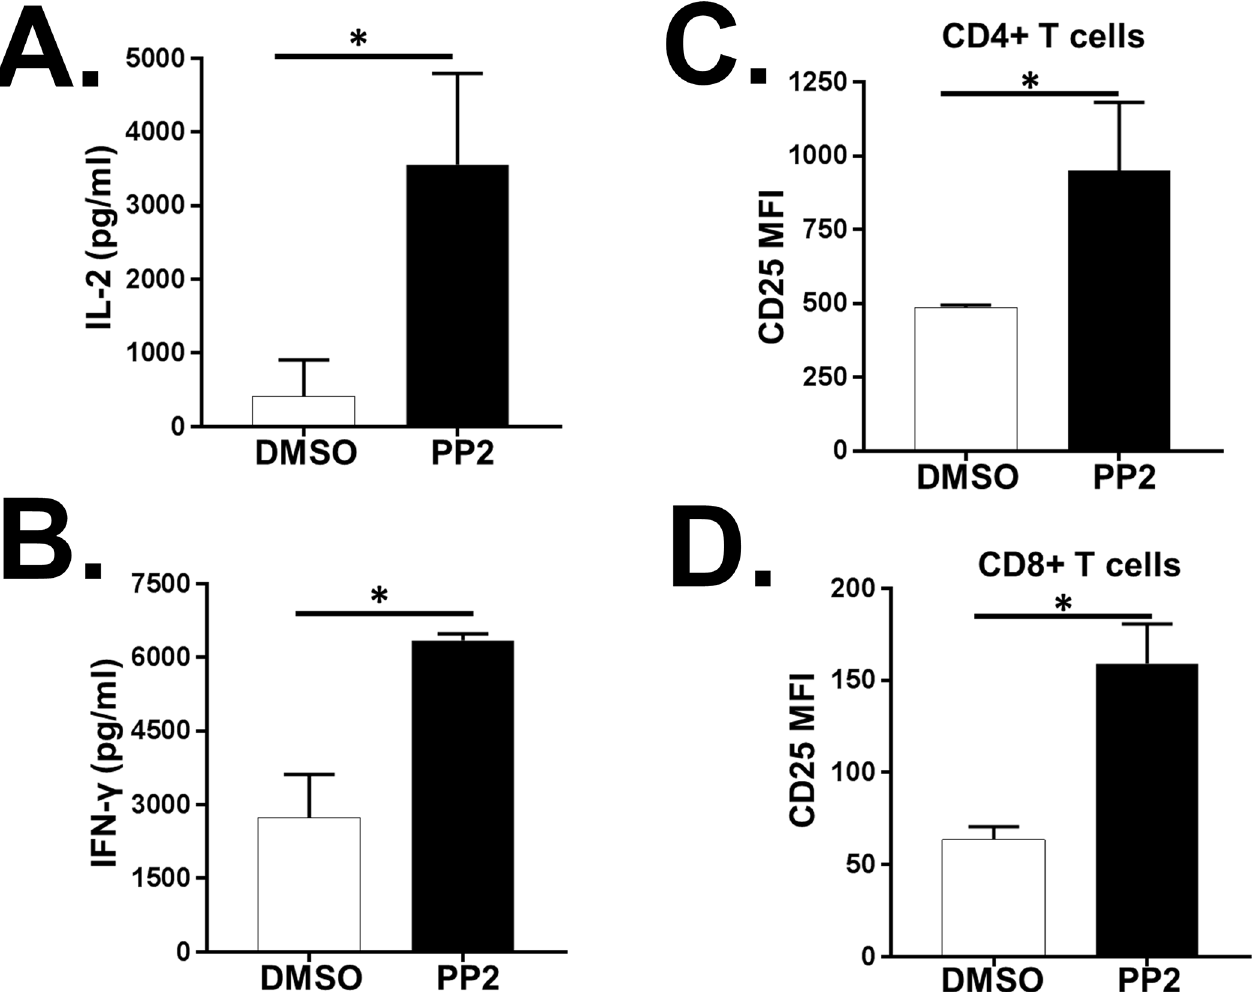
Fig 6. Inhibition of Src-family kinases (SFKs) enhances distal T cell receptor (TCR) signaling in primary human T cells. Primary humanT cells obtainedfrom healthyblood donors were treated with DMSO alone or PP2. Followingstimulationwith PMA/ Ionomycin, distal TCR signaling was measuredby assessing IL-2 (A), IFN- γ (B) release and CD25surface expression on CD4+ (C) and CD8+ (D) T cells. MFI = mean fluorescent intensity. Data represent the averageof three technicalreplicates, and the standarddeviationis shown. Each experiment was independently performed with three different donors with similar results. * P <